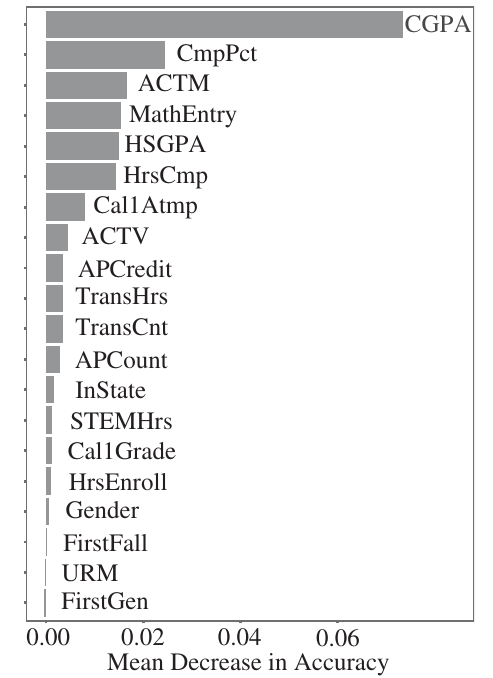
FIG. 2. Physics 1: Variable importance for institutional varia- bles. High values represent more important variables for the goodness of fit of the random forest models.